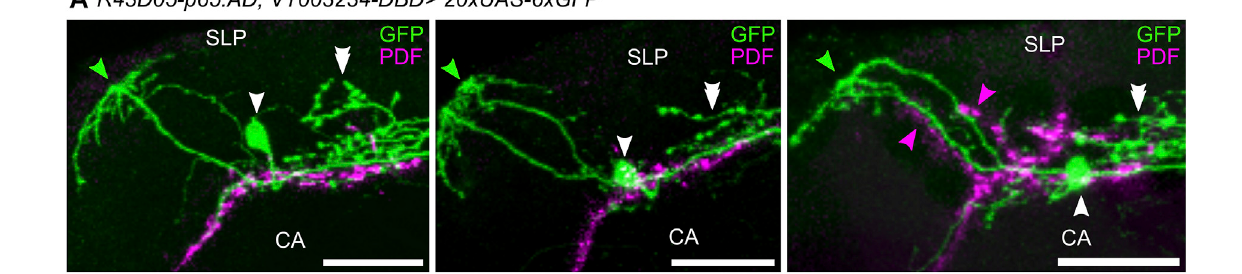
FIGURE 11 | Vicinity of the DN2s to other clock neurons and putative downstream synaptic partners. (A) Confocal images (overlay of 27, 43, and 21 stacks, respectively)demonstratingtheclosevicinityoftheDN 2 s(green)tothePDF-positiveterminalsofthes-LN v s(magenta).Labelingasin Figure9 . (B) Maximalprojectionof 18confocalplanesshowingtheclosevicinityoftheDN 2 s(green)totheITP-positiveLN d and fi fthLN(magenta)andthePDF-positiveterminalsofthes-LN v s(cyan).White arrowsmarktheoverlapofITP-positive fi berswiththecontralateralprojecting fi bersoftheDN 2 sinthesuperiormedianprotocerebrum(SMP)andthemiddledorsal commissure (MDC). (C) Overlay between DN 2 and CRY-positive DN 1p fi bers running around the SLP to the anterior optic tubercle (AOTU). (D) Neurons postsynaptic to the DN 2 s revealed by trans- Tango. Top: maximal projection of eight confocal planes from the anterior brain depicting postsynaptic HA staining in neurosecretory cells (NC) running in the median bundle (MBDL) and around the esophagus (ES) to the subesophageal zone (SEZ) as well as in the α - and β -lobes of the mushroom bodies.